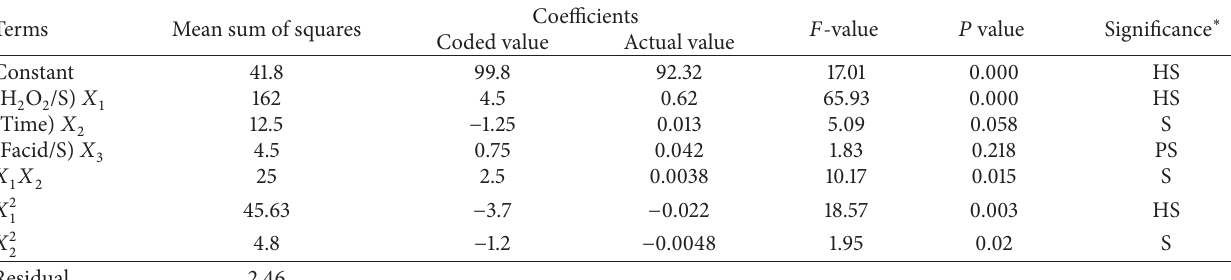
Residual 2.46 ∗ HS: highly significant, S: significant, and PS: possibly significant.